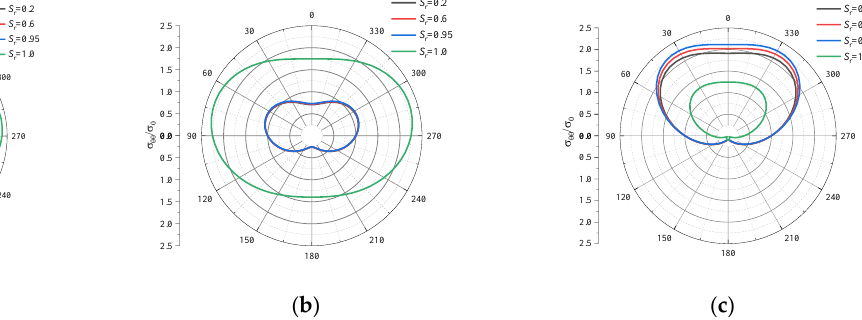
  around the surface of the cavity for P 1 / / σ 0 around the surface of the cavity for P 1 wave  0 θθ